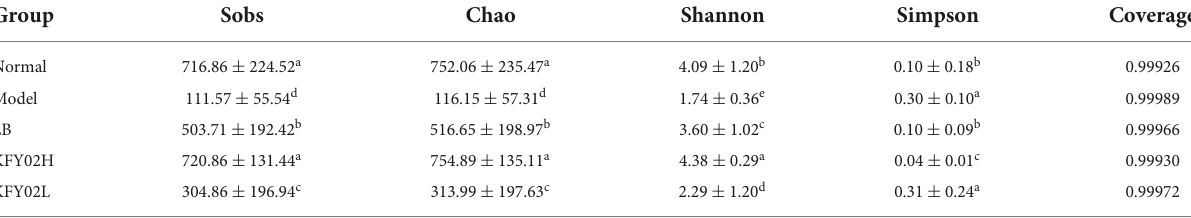
TABLE 2 The alpha diversity in mice